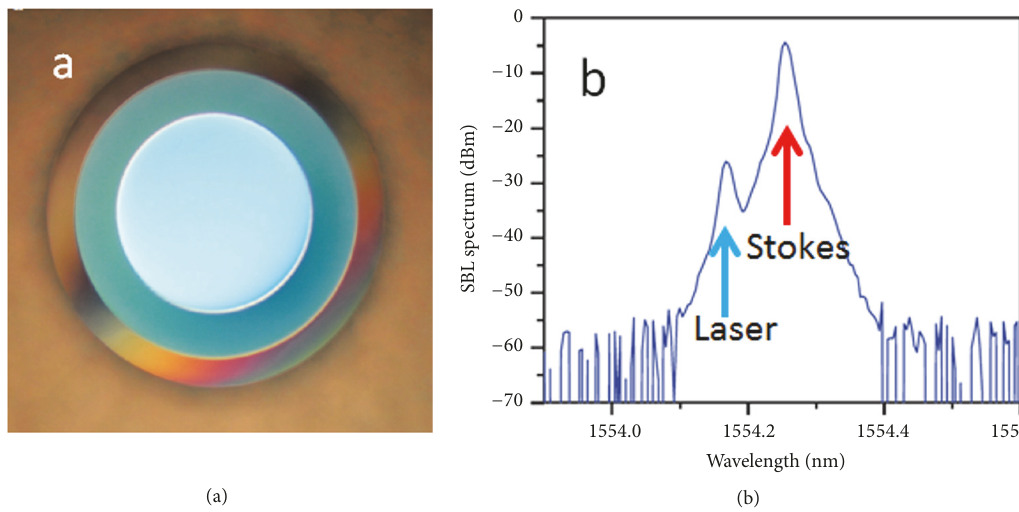
Figure 17: (a) Ring resonator for SBS laser, 1 mm in diameter; (b) Brillouin scattering spectrum [adapted from [20]].